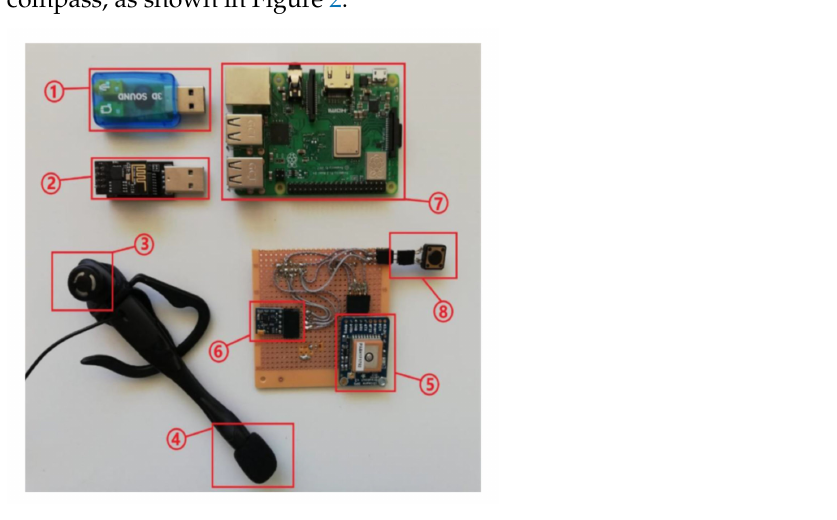
Figure 2. Central unit hardware components: (1) external soundboard with USB interface; (2) ESP8266-01 Wi-Fi module with a serial-to-USB converter; (3) speaker; (4) microphone; (5) GPS Adafruit Ultimate module; (6) electronic compass; (7) Raspberry Pi model 3B+ minicomputer (6), and (8) push